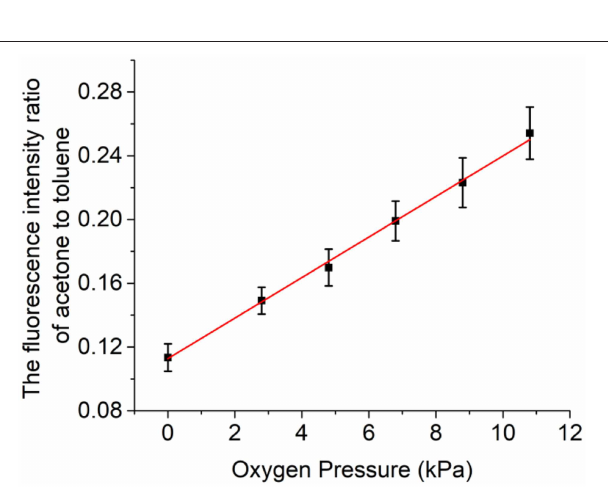
of acetone on toluene fluorescence signal needs to be